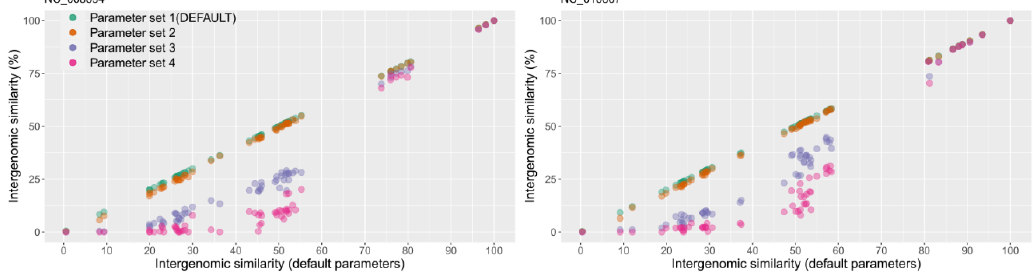
Figure 1. Comparison between the intergenomic similarity values produced with the default BLASTN alignment parameters (parameter set 1: -word_size 7 -reward 2 -penalty -3 -gapopen 5 -gapextend 2) and parameter sets of increasing stringency. Parameter set 2: “-word_size 11 -reward 2 -penalty -3 -gapopen 5 -gapextend 2”. Parameter set 3: “-word_size 20 -reward 1 -penalty -2”. Parameter set 4: “-word_size 28 -reward 1 -penalty -2”. For illustration, the similarity values between two viral genomes (NCBI accession NC_008694 and NC_010807) and all the other genomes in the benchmarking dataset were chosen. On the X axis are plotted the intergenomic similarity values as calculated with the parameter set 1. On the Y axis are plotted the intergenomic similarity values as calculated with each of the four parameter sets. The plot was generated with the ggplot2 R package [22].